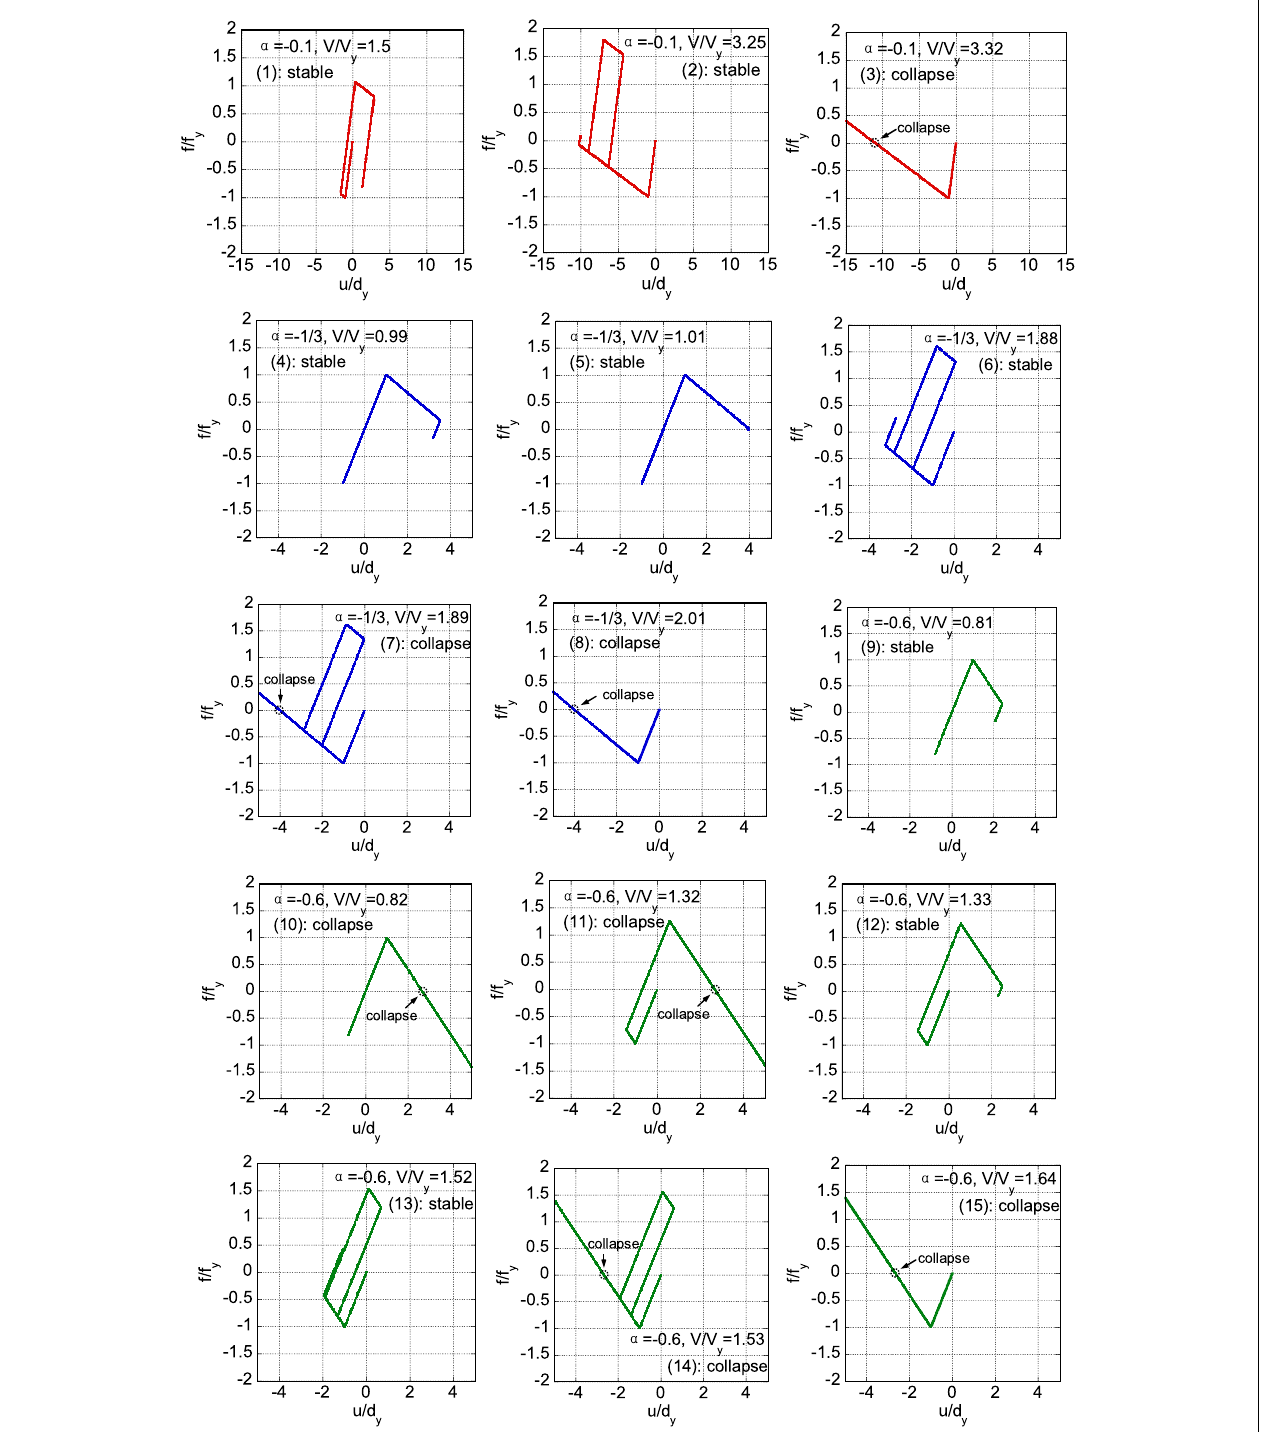
FIGURE 12 | Restoring force–deformation relations for 15 models in stable and unstable regions .